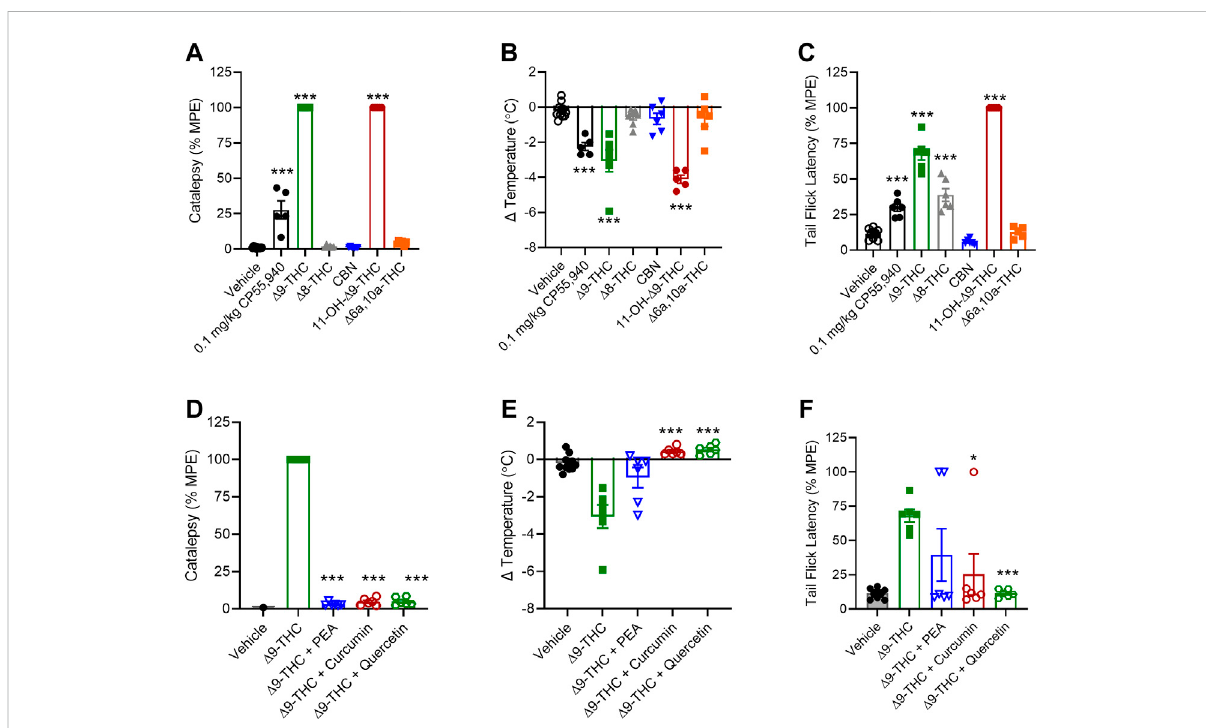
FIGURE 6 Invivo effectsofcannabinoidsandselectphytomoleculesinmaleC57BL/6mice.Malemiceweretreatedwith10 mg/kgcannabinoids (A – C) or 10 mg/kg Δ 9 -THC + 10 mg/kg select phytomolecules i. p. (D – F) and assessed for catalepsy 5 min post-injection (A,D) , body temperature 15 min post-injection (B,E) , and nociception in the tail- fl ick assay 20 min post-injection (C,F) . Data for catalepsy are represented as % MPE during a maximum60 strial.Dataforthetail- fl ickassayarerepresentedas%MPEduringamaximum20 strial.AlldatawereanalyzedinGraphPad(v.9). n = 5 – 10 animals per treatment group. Data are expressed as mean ± SEM. * p < 0.05, ** p < 0.01, and **** p < 0.001 as determined by